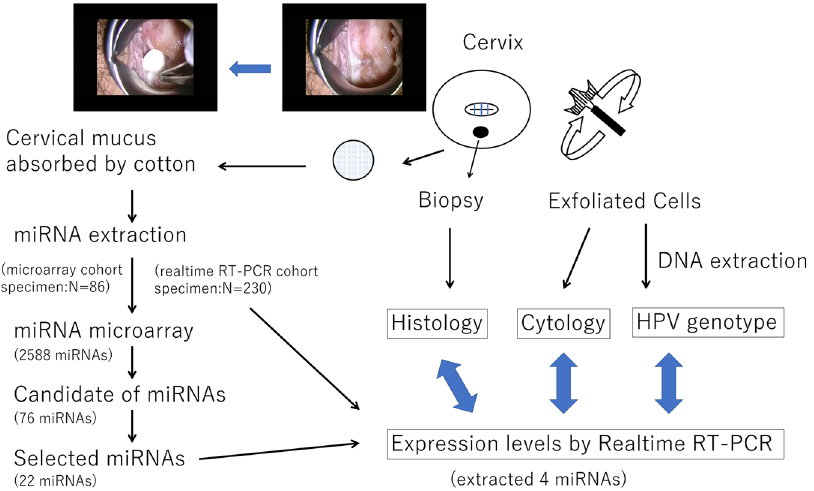
Figure 1. Analytical strategy for identification of miRNAs. A cotton swab was used to collect the cervical mucus. The primary screening was performed on the microarray cohort (n = 86) using a miRNA array. A validation assay with real-time RT-PCR was then performed on the real-time RT-PCR cohort (n = 230). Exfoliated cells and biopsy samples were taken from the cervix. The expression levels of miRNAs by real-time RT-PCR were examined along with information from histology, cytology and HPV